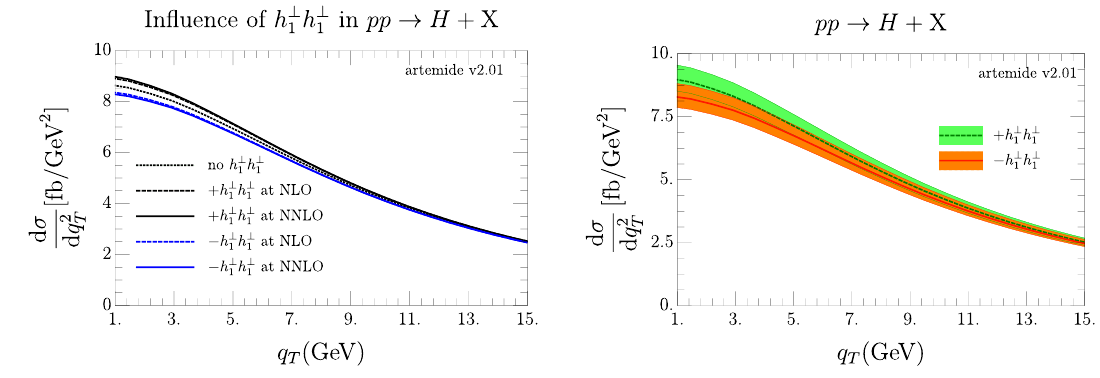
Figure 3 . Cross section for Higgs production including linearly polarized gluon e(cid:11)ects at di(cid:11)erent orders. (left) The motion of center lines of cross-section integrated over all rapidities at di(cid:11)erent perturbative orders for lpTMDPDF. The black (blue) lines correspond the case of positive (nega- tive) contribution for h ? h ? -term in eq. (4.3). (right) The scale-variation band for the cross 1 1